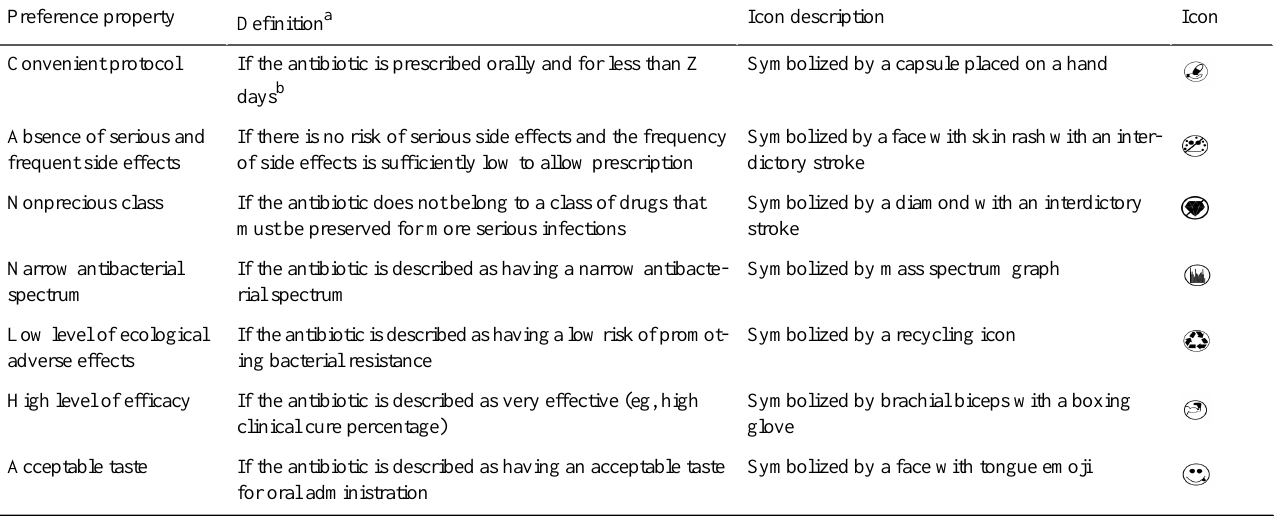
Table 1. Icons used for displaying antibiotic